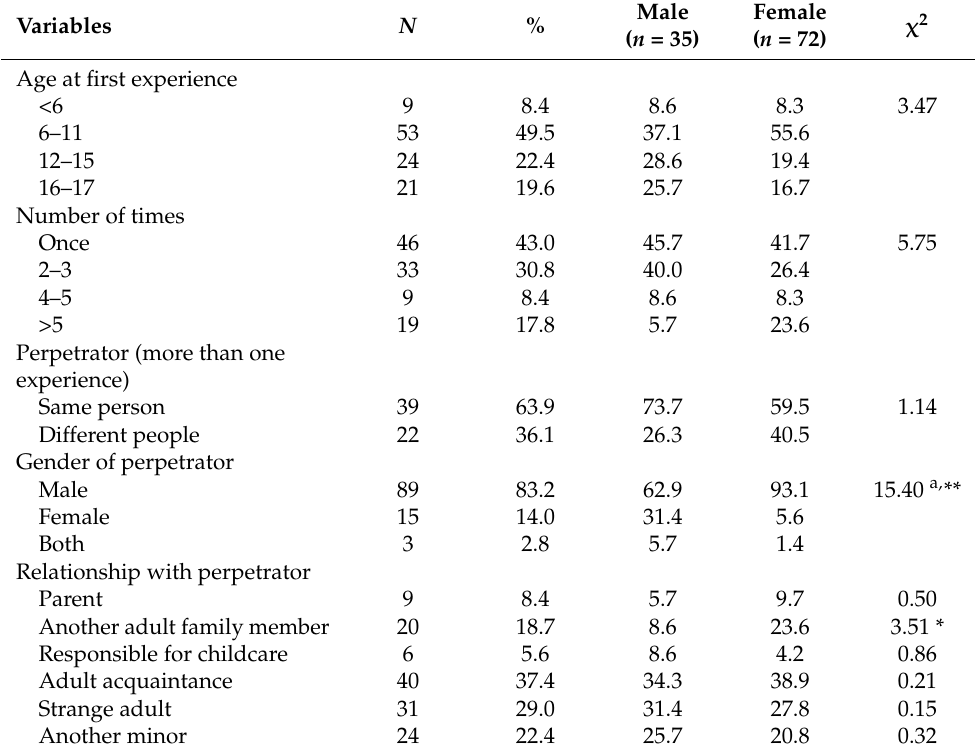
Table 3. Percentage of victims’ age at the first experience and perpetrator’s characteristics as a function of gender for “somebody touched my private